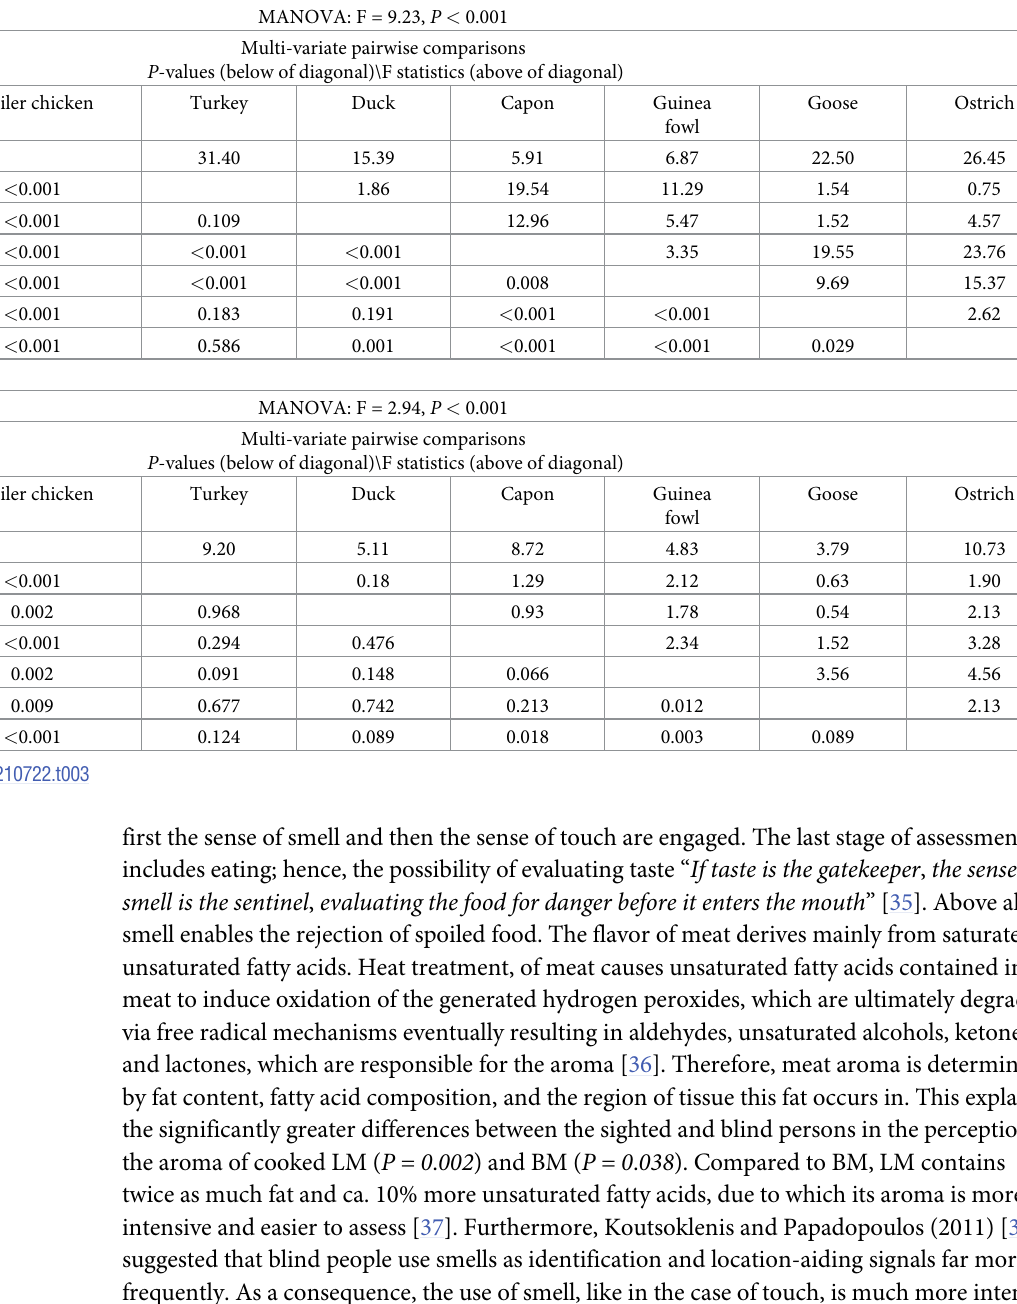
MANOVA: F = 9.23, P < 0.001 Multi-variate pairwise comparisons